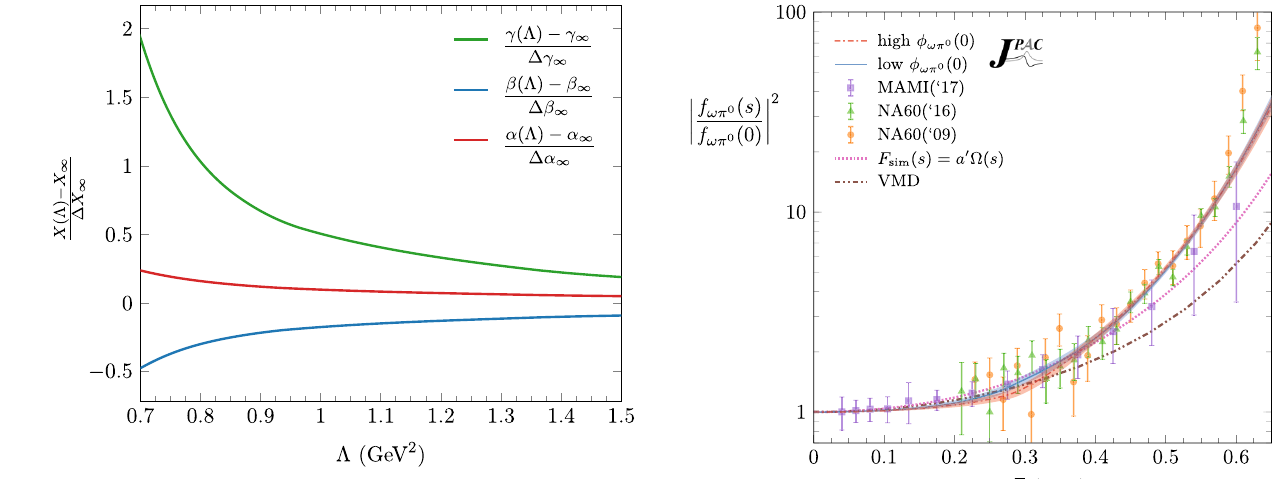
Fig. 6 Dependence of the Dalitz plot parameters ( X = α,β,γ ) when acutoff (cid:22) isusedasanupperintegrationlimitintheTFFdispersiverep- resentation,Eq.(2.28).Thisdependenceisusedtoestimateasystematic uncertainty. See the text for more details